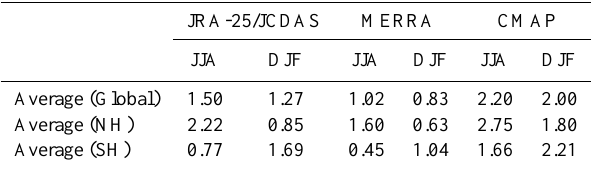
Table 1. Seasonal mean convective precipitation and total precipita- tion rates (mm d − 1 ) from the JRA-25/JCDAS, MERRA and CMAP datasets respectively averaged globally, over the Northern Hemi- sphere (NH) and over the Southern Hemisphere (SH). JRA-25/JCDAS MERRA CMAP JJA DJF